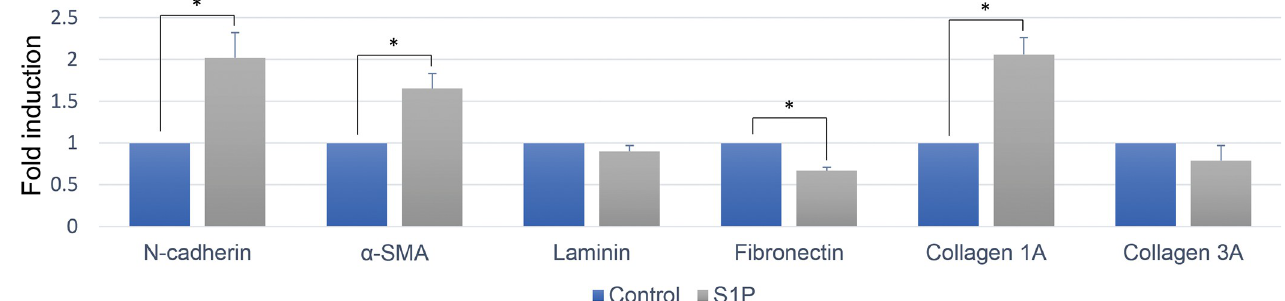
Fig 5. Changes in mRNA expression according to 10mM sphingosine-1-phosphate (S1P) treatment. Relative folds expression levels for indicated genes were determined by RQ-PCR with normalization to GAPDH levels (mean ± SEM, from 3 experiments, � P < 0.05).